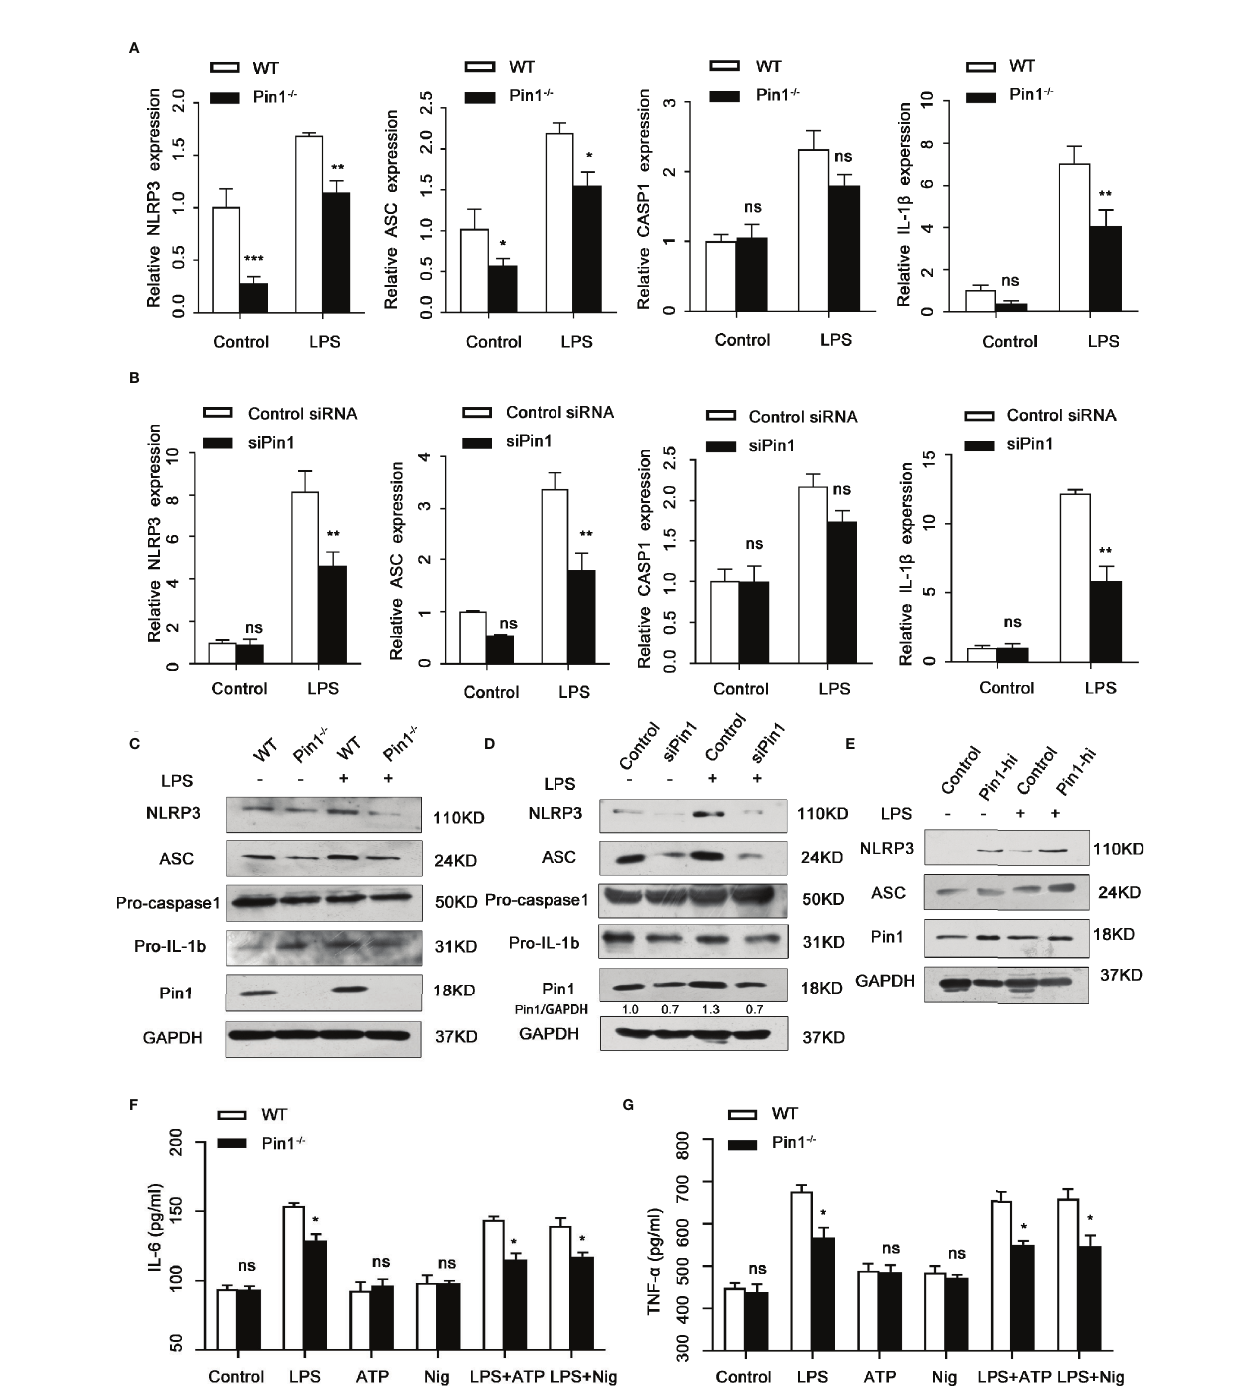
FIGURE 3 | Pin1 regulates NLRP3 expression and transcription in macrophages. (A) Nlrp3 , Asc , Casp1 , and IL-1 b mRNA levels in LPS-treated WT and Pin1 -/- bone marrow-derived macrophages (BMDMs). (B) Nlrp3 , Asc , Casp1 , and IL-1 b mRNA levels in lipopolysaccharide (LPS)-treated RAW 264.7 cells transfected with control siRNA or siRNA for Pin1. (C) IL-1b and NLRP3 in fl ammasome protein levels in LPS-treated WT and Pin1 -/- BMDMs after 4 h. (D) IL-1b and NLRP3 in fl ammasome protein levels in LPS-treated RAW 264.7 cells transfected with control siRNA or siRNA for Pin1 after 4h. (E) RAW 264.7 cells with high Pin1 expression (Pin1-hi) were primed with 500 ng/ml LPS for 4h, lysates were immunoblotted for NLRP3 and ASC. (F, G) WT and Pin1 -/- BMDMs were treated without stimulation (control) or with LPS (500ng/ml), ATP (5mM) or nigericin (20mM) alone, LPS for 4 h and 5 mM ATP or 20 mM nigericin for 30 min. The secretion of IL-6 and TNF- a in culture supernatant were analyzed. The data represent the mean ± SD of one among three biological replicates, with three technical replicates each. *P < 0.05; **P < 0.01; ns, no signi fi cance; two-way ANOVA (A, B, F, G)